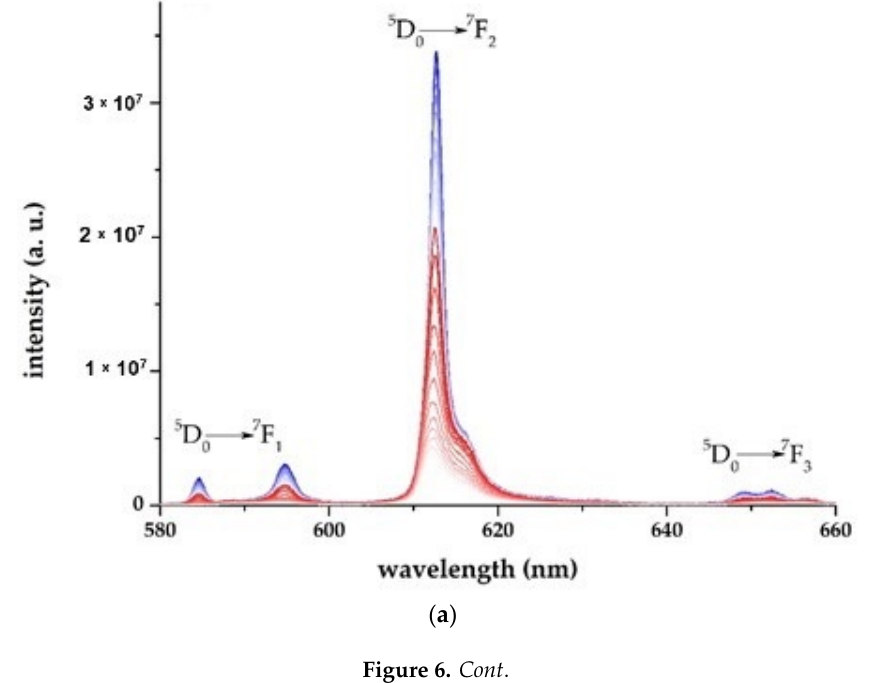
( b ) Figure 6. ( a ) emission spectra of 1/PSU at different temperatures upon excitation at 320 nm. Most intense blue line at room temperature, less intense red line acquisition ate 135 °C; ( b ) total intensity of 5 D 0 → 7 F 2 transition band between 25 and 100 °C with 5 °C step, y = − 1.43x + 1.70 (r 2 = 0.99). In Figure 7a we present the emission spectra of [Chol][Eu(fod) 4 ]/PSU with 10% loading of Eu (III) complex when exposed at temperatures between 25 and 160 °C. The feature that allows the ratiometric relation found and presented in Figure 7b is the relative increase of the intensity of the shoulder at 616 nm, from low to higher intensities as the temperature increases. Figure 6b represents the relations found between the total integrated intensity of the 5 D 0 → 7 F 2 relative to the total intensity of the 5 D 0 → 7 F 1 magnetic transition for the [Chol][Eu(fod) 4 ]/PSU membrane. A polynomial fit can be used to relate ratiometrically the emission bands intensity with temperature, with the equation y = 0.875 + 0.597x – 0.024x 2 + 4.66 × 10 − 4 x 3 . Above 100 °C we did not consider the ratiometric relation due to a random variation of the ratio, eventually caused by reduction of chemical stability of the Eu (III) complex.